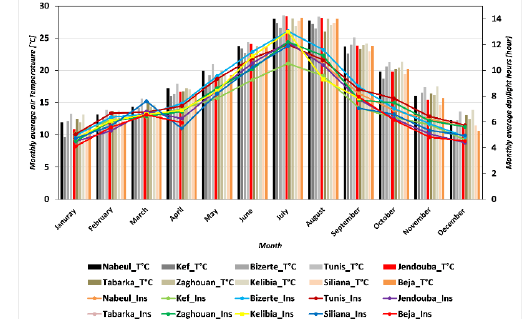
Figure 2. Monthly average air temperature [°C] and actual duration of sunshine [hour] in the 10 meteorological stations included in the Medjerda Basin for the year